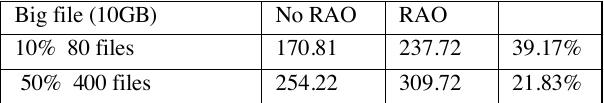
Table 7 Random Spacing, RAO effects for 10 GB